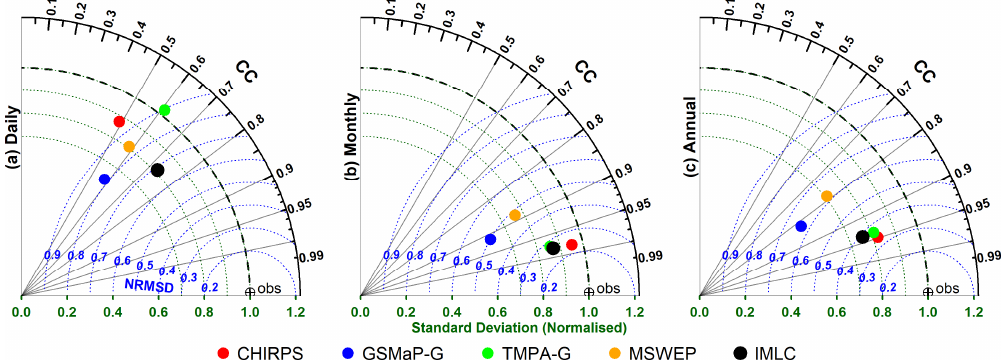
Figure 11. Taylor diagrams plotted for the ( a ) daily, ( b ) monthly, and ( c ) annual time series of